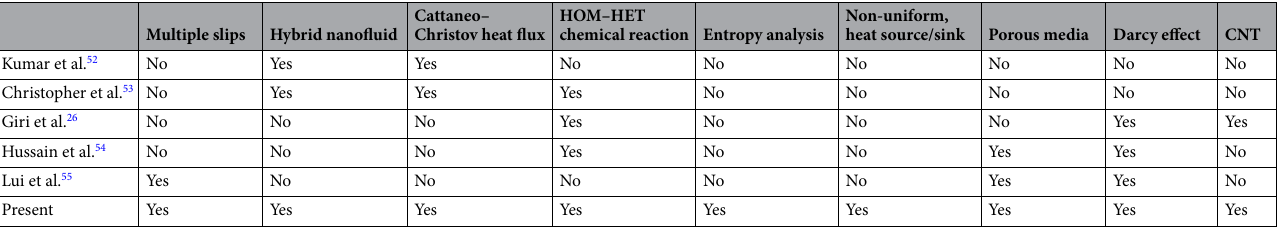
Table 1. Comparison of the present model with the contemporary